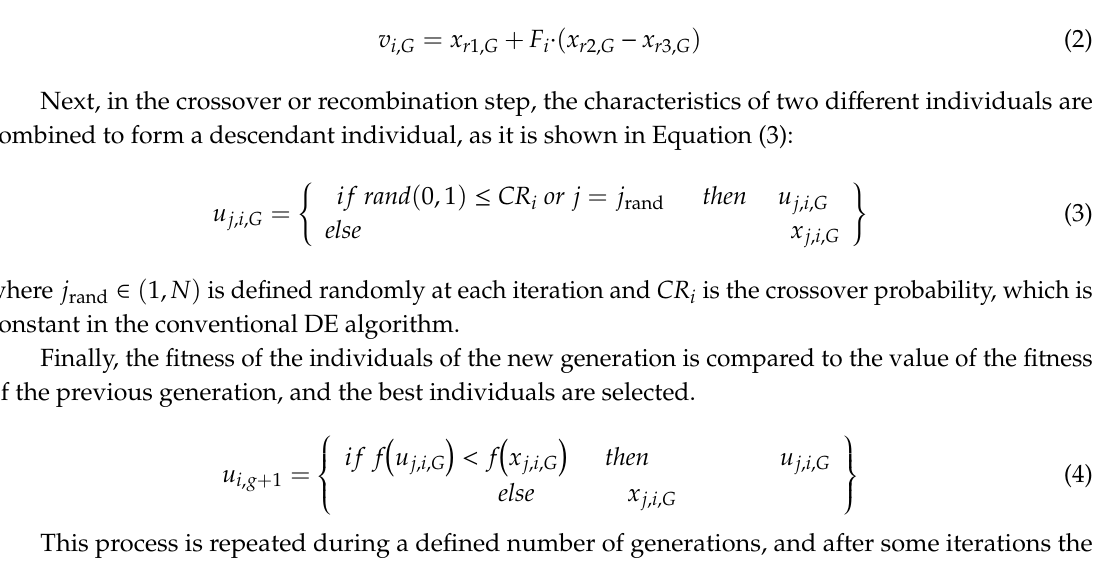
Figure 1. Pipeline of the operating principle of a Differential Evolution (DE) optimization algorithm.